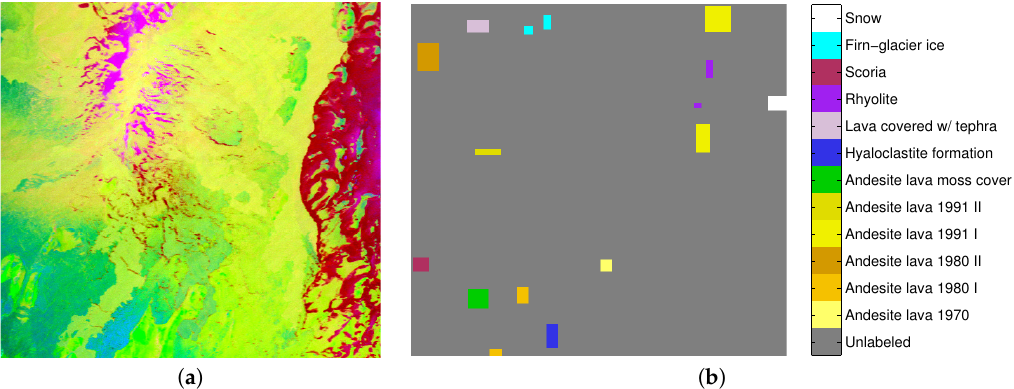
Figure 10. Hekla HSI. ( a ) First three components of MNF transform; ( b ) ground